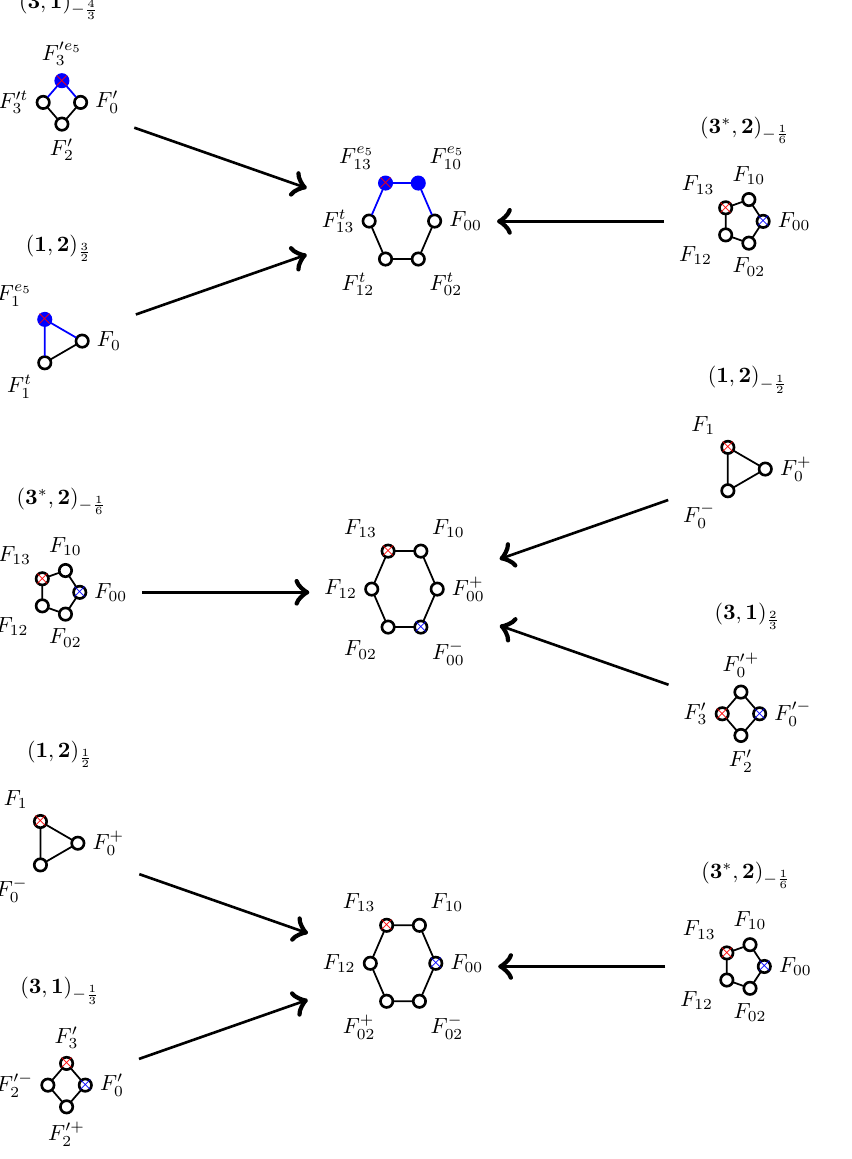
Figure 5 . Singular fibers associated to Yukawa interactions of the form ( 3 ∗ , 2 ) w ( 1 , 2 ) w 00 ¯ 1